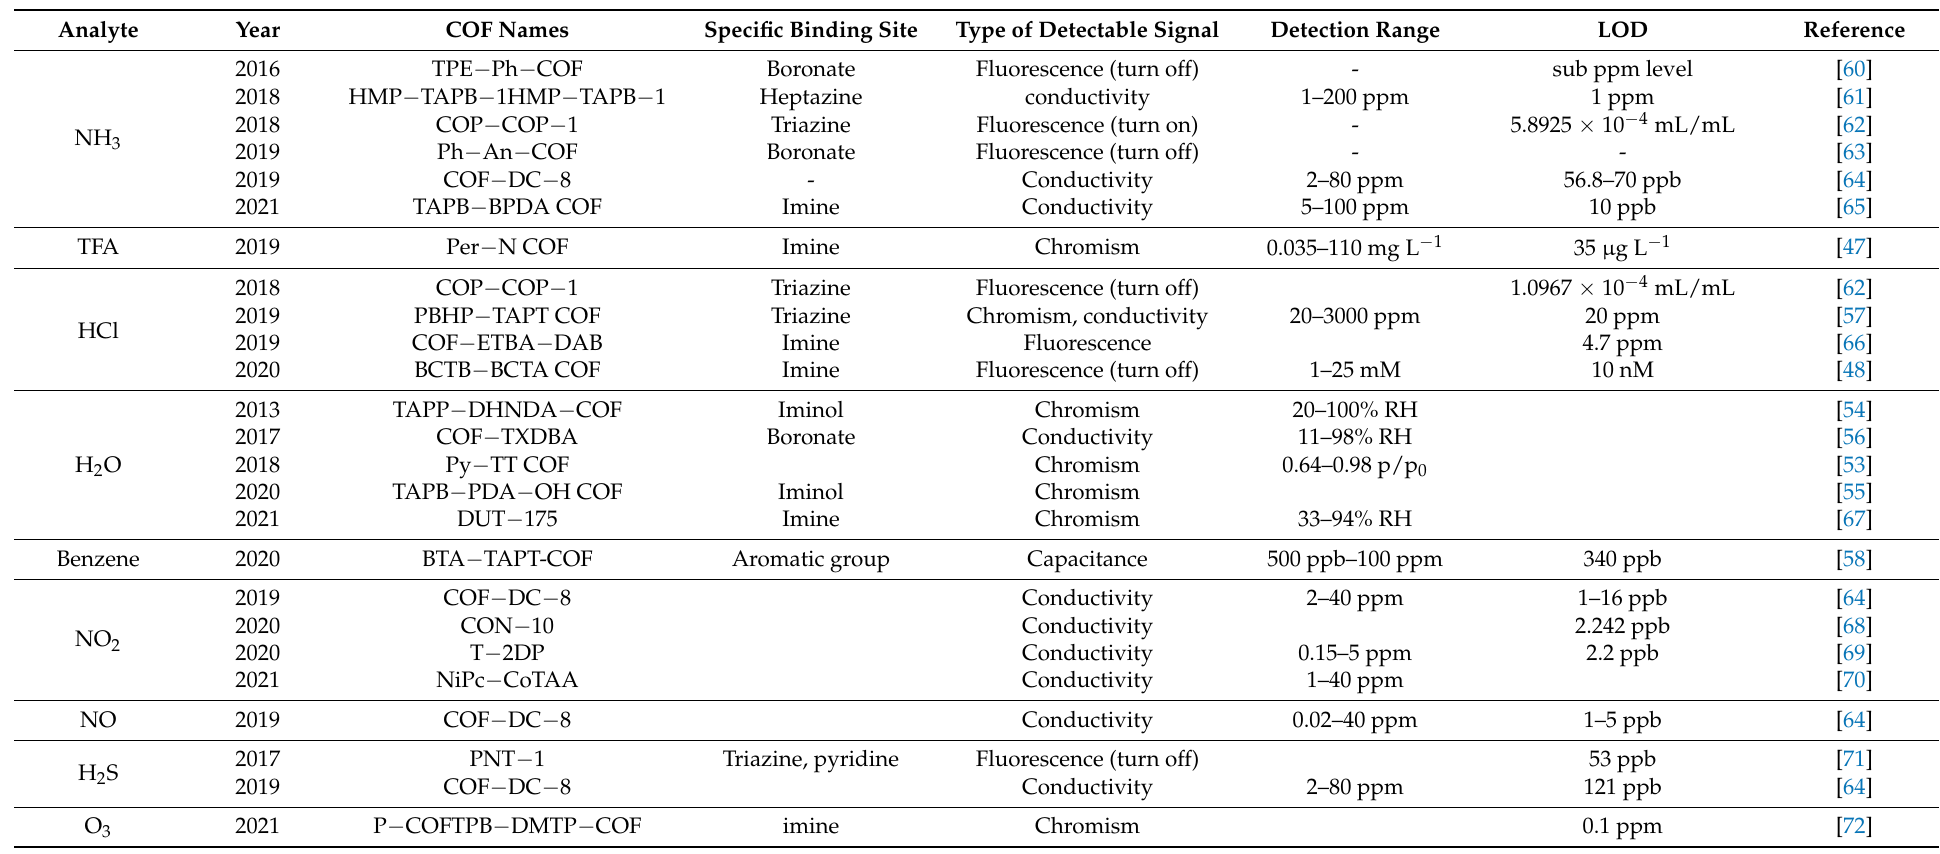
Table 2. COF-based gas